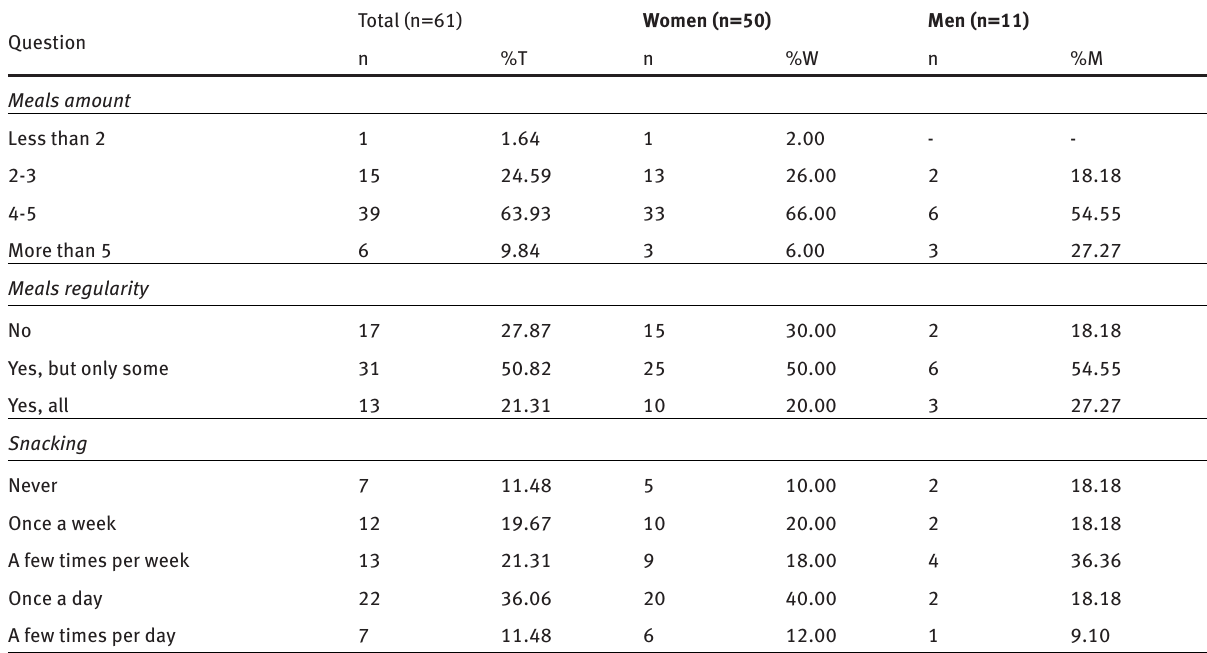
Table 4: General eating habits of the U3A